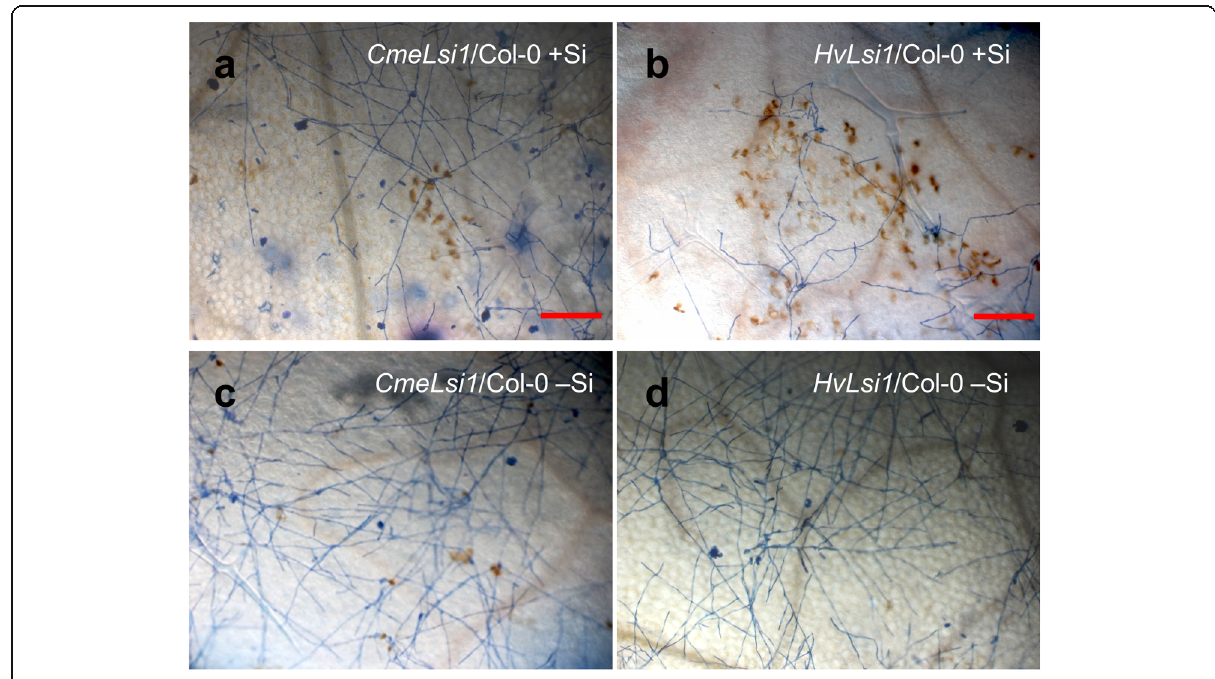
Fig. 4 High Si content enhances H 2 O 2 production in leaves of Col-0 plants expressing a heterologous silicon transporter . a, b, c and d Representative microscopic images showing growth of Gc UCSC1 at 5 dpi on leaves of the plants of the indicated genotypes grown in perlite supplemented with 0 mM ( − Si) or 1.0 mM (+Si) Si. Production and in situ accumulation of H 2 O 2 was visualized as reddish-brown stain upon reaction with 3,3-diaminobenzidine, while fungal structures were stained blue by trypan blue. Scale bars = 200 μ